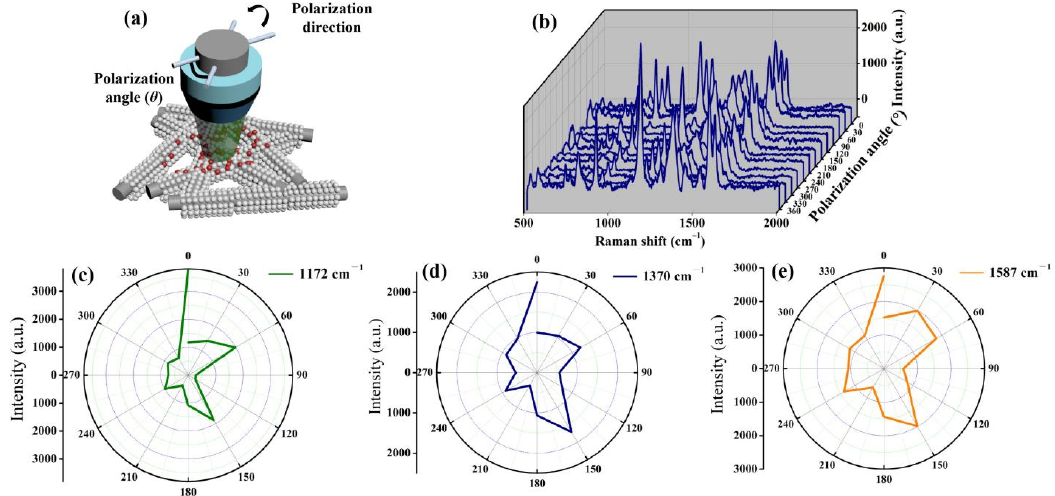
Figure 7. ( a ) The principle diagram of polarization measurement of Ag 25 -C-fiber SERS substrate; ( b ) SERS spectra of CV at different polarization angles on the Ag 25 -C-fiber substrate; ( c – e ) polar curves of the Raman intensities at 1172, 1370 and 1587 cm −1 characteristic peaks.